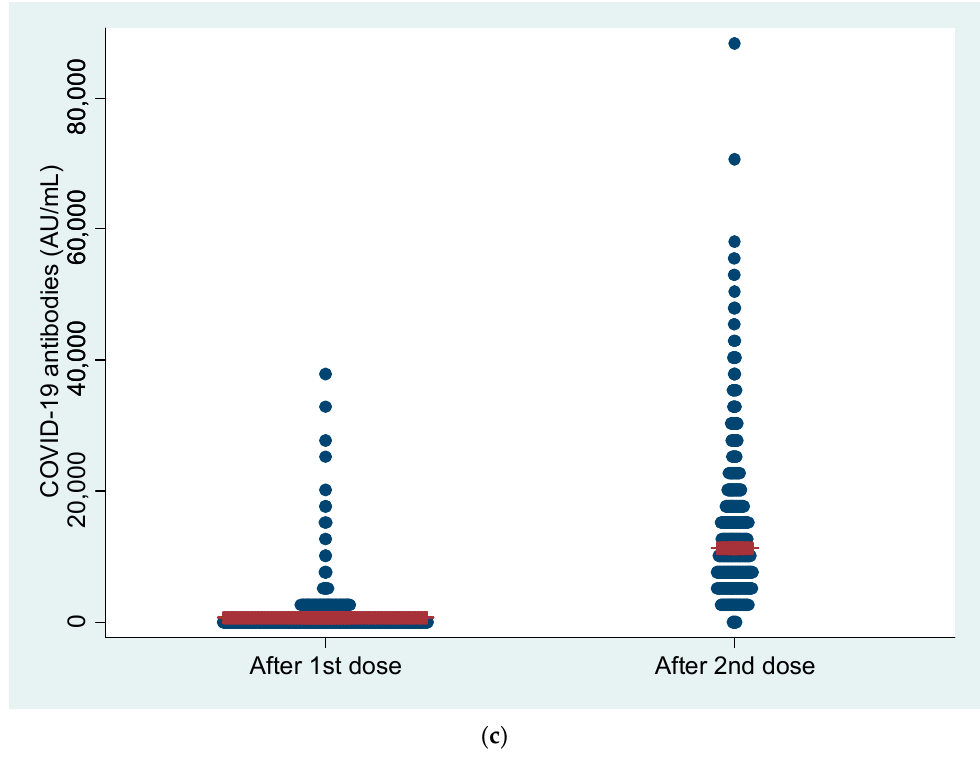
Figure 1. ( a ) Antibody concentration after the first dose. ( b ) Antibody concentration after the second dose. ( c ) Dot plot for antibody titers before and one month after the second dose. Note: red line represents the GMT (Geometric Means Titers). Changes in antibody levels during follow-up for different groups are shown in Table